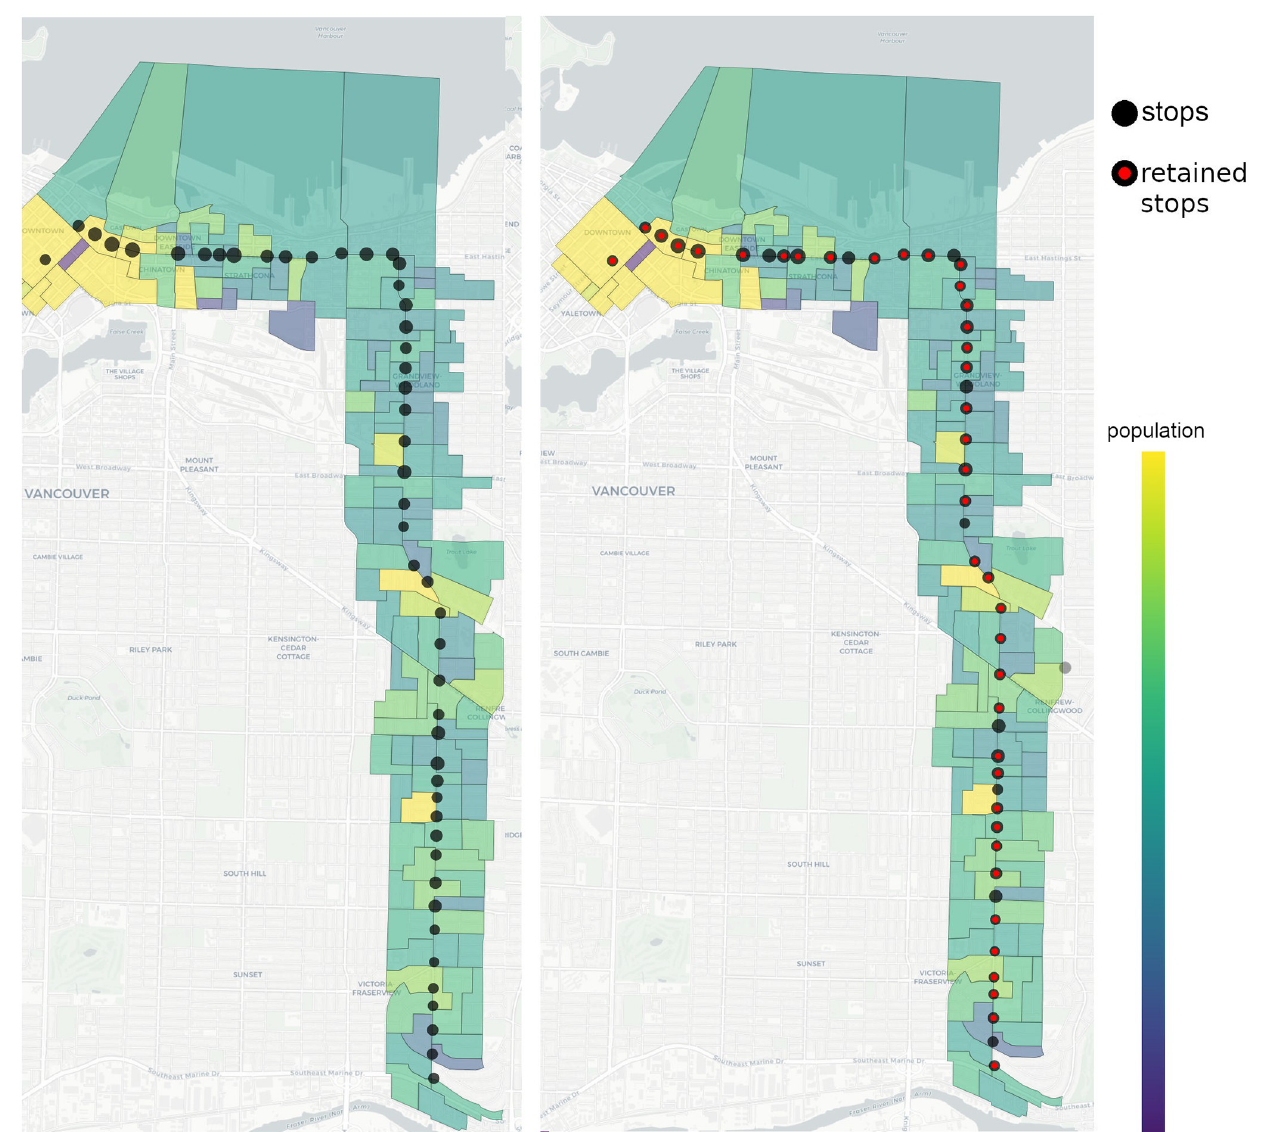
Fig 6. Vancouver northbound B20 route with dissemination areas; unoptimized (Left), optimized (Right). The black dots (bus stops) have different sizes according to their weight w j . The plot on the right demonstrates the optimized route where the retained stops are marked in